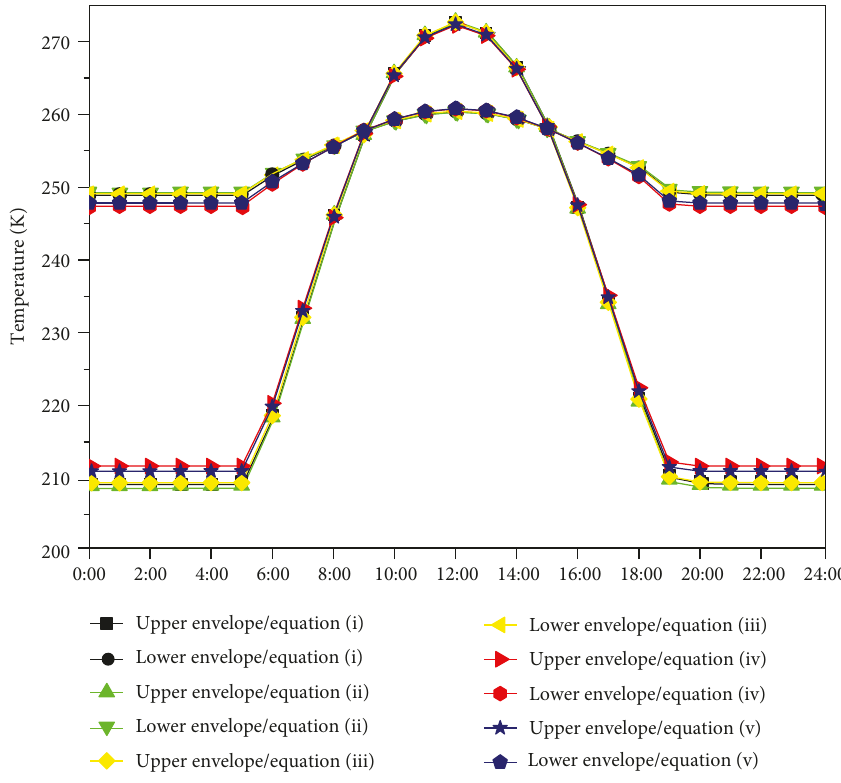
Figure 3: Envelope temperatures calculated by di ff erent natural convection